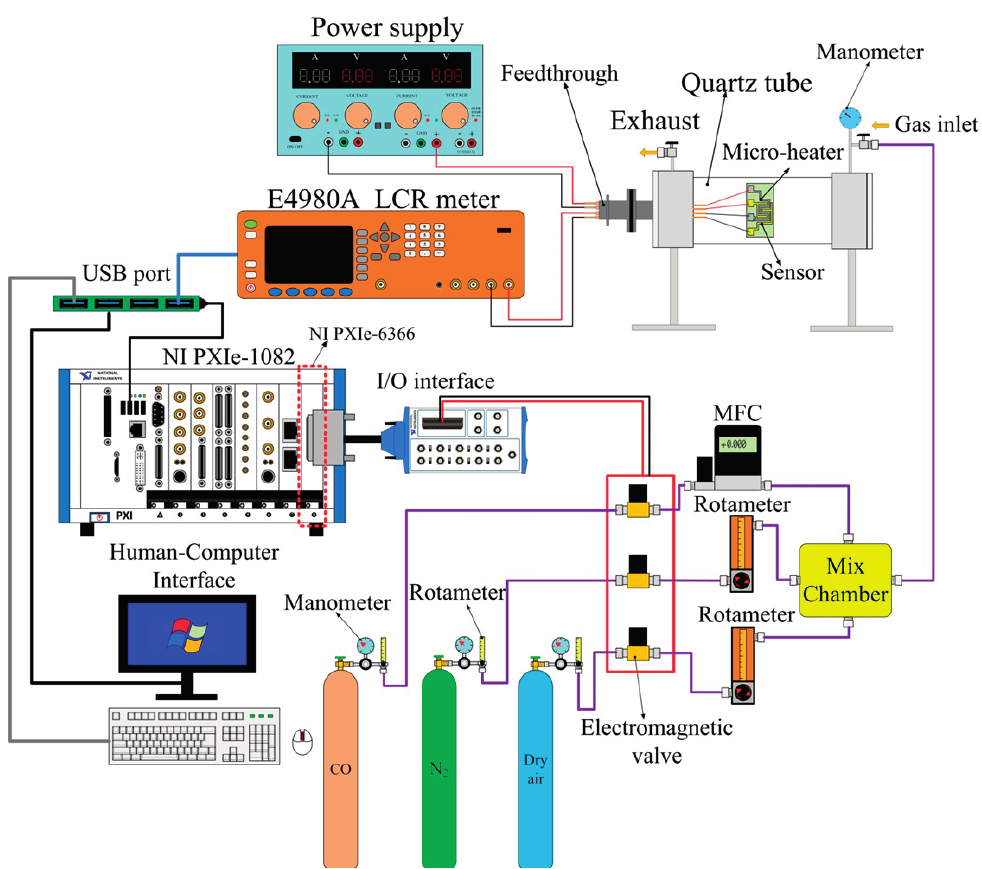
Figure 6. Schematic diagram of a computer-controlled gas sensing characterization